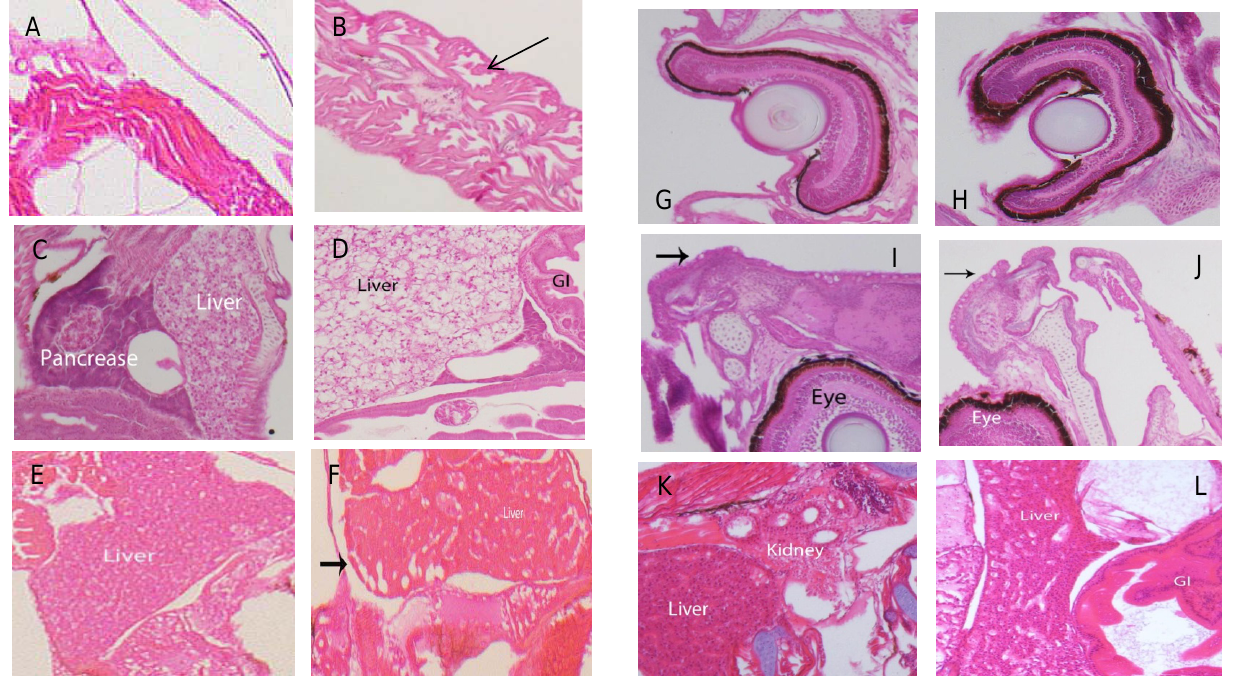
Fig. 7. Photomicrographs of H&E-stained tissue sections taken from 21dph (A–F) and 28dph (G–L) summer flounder larvae. Photomicro- graphs on left (A, C, E, G, I, K) are from ambient (low)-CO 2 level; those on right (B, D, F, H, J, L) are from the high-CO 2 level. (A, B) Skeletal muscle. (C, D) Liver (lipid or glycogen vacuolation) and pancreas. (E, F) Liver (eosinophilic hepatocytes and chord-like structure). (G, H) Eye showing cornea, lens, iris, and retina. (I, J) Epidermis. (K, L) Kidney (renal tubules) and liver. Notes: (B) arrow shows disruption of skeletal muscle fibers within the bundles. (C–F) Livers of some 21dph larvae had a vacuolated appearance (C, D) and others had a more distinct chord-like architecture (E, F) , but in both types the liver architecture in the high-CO 2 group was disrupted and more apparent as dilated sinusoids ( F , arrow) and focal hepatocyte necrosis. (G, H) No significant differences among groups were observed in the eye. (I, J) Epidermal hyperplasia was evident with a marked increase in goblet cells (arrows). (K, L) Livers from the 28dph high-CO 2 group (L) showed dilated sinusoids and focal necrosis when compared to the low-CO 2 group (K)